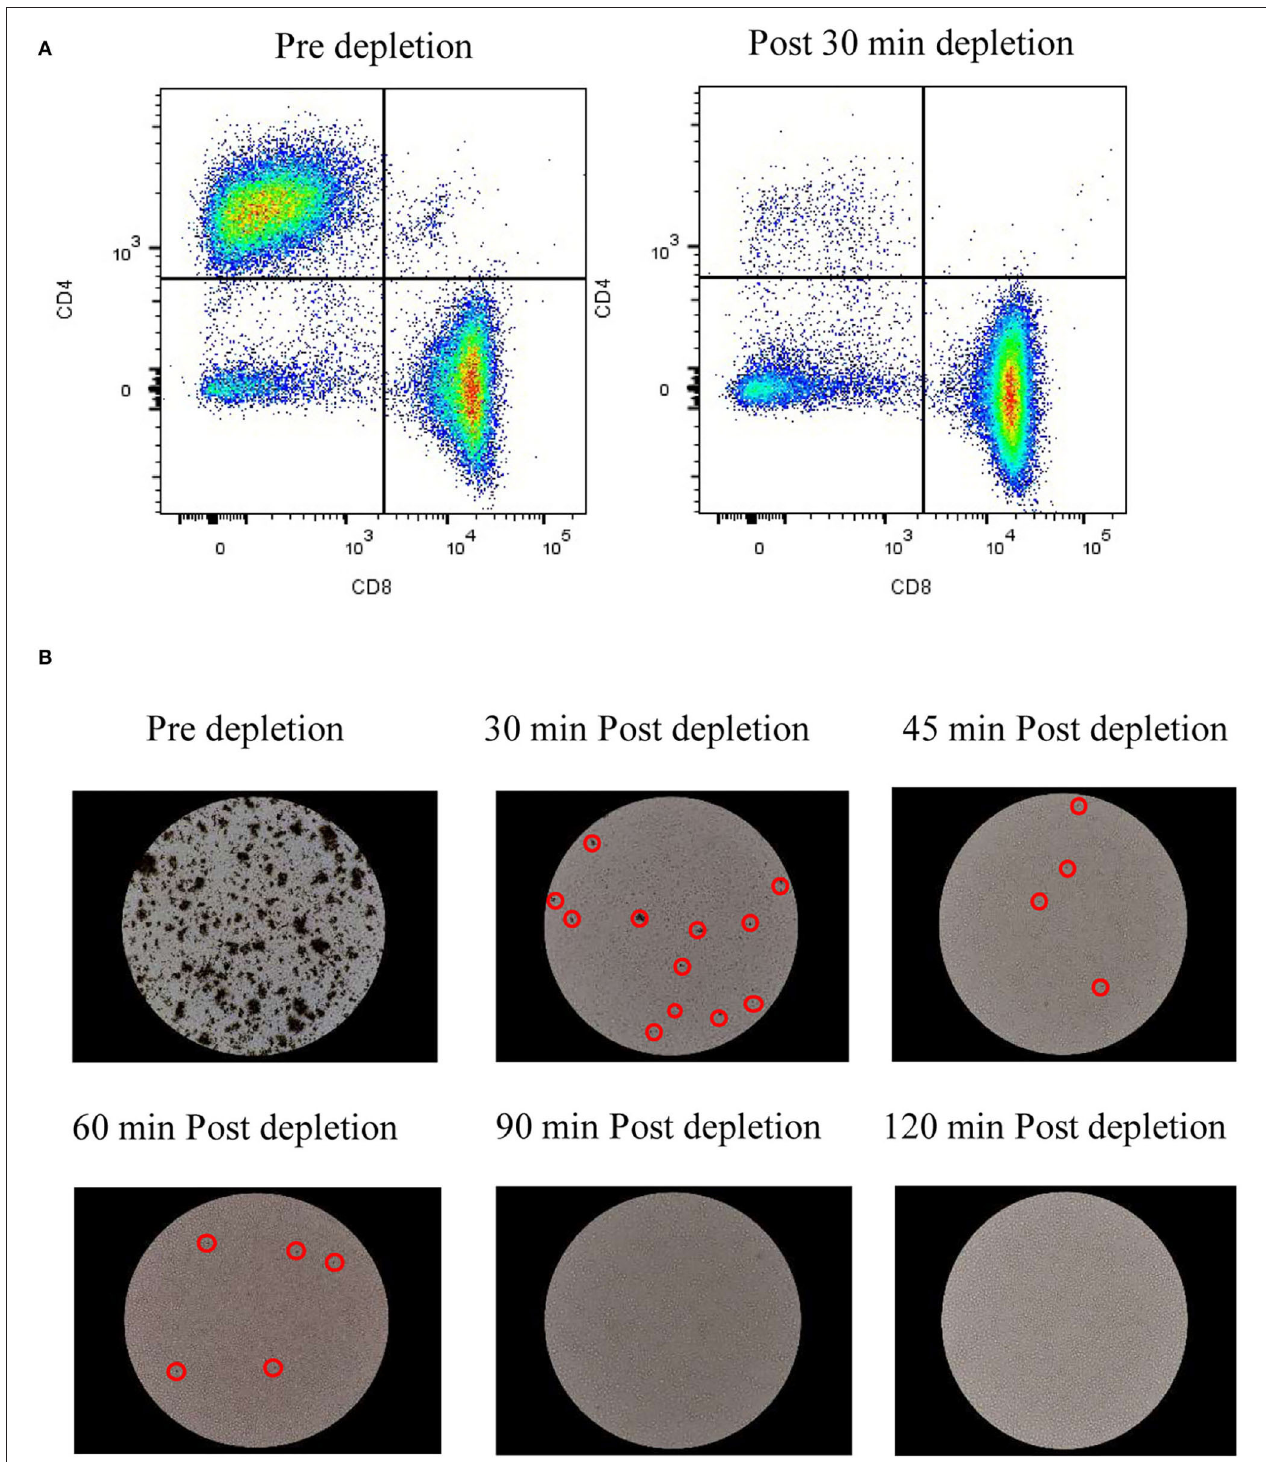
FIGURE 5 | In-vessel cell depletion results in CD4 + T cell and bead depletion effectively: (A) Dot plots from flow cytometry analysis of CD8 + T cells vs. CD4 + T cells pre depletion and 30min after depletion. The values represent average of 50,000 single cells per condition; (B) Images of beads in cell culture at 20X magnification before bead depletion and after incubation with magnets for specified time. The values represent reading from one experiment, unless mentioned otherwise.